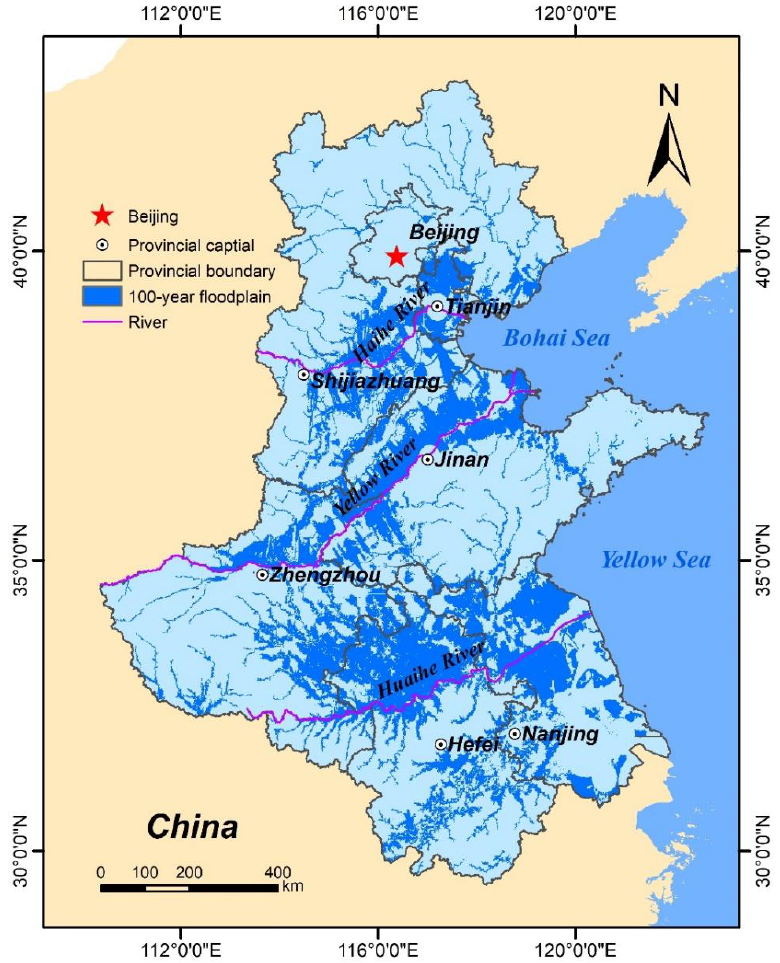
Figure 3. Spatial-temporal distribution of floodplains in the North China Plain Area (NCPA).